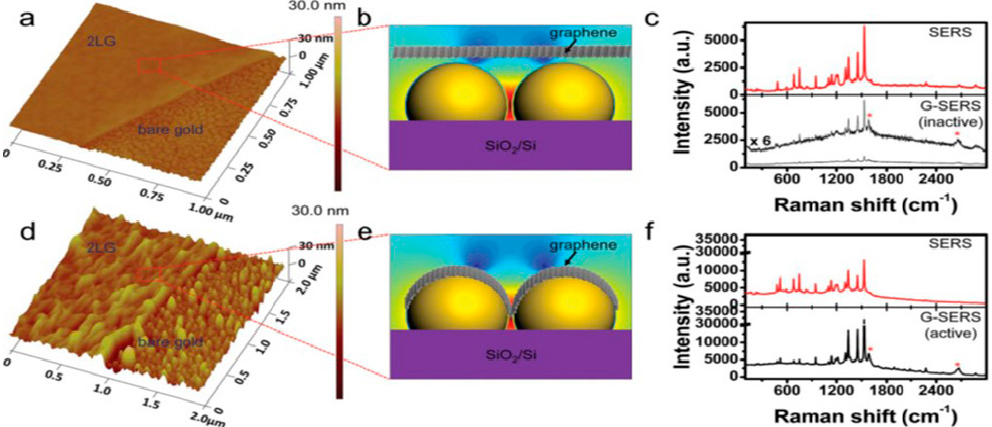
Figure 12. Morphology-dependent SERS performance of normal SERS and graphene-mediated SERS (G-SERS). ( a , d ) AFM images of a bilayer graphene (2LG)-covered 8-nm gold film ( a ) before, and ( d ) after annealing, showing both the bare gold regions and graphene-covered regions; ( b , e ) Schematic illustration of the contact state between graphene and AuNS correspond to the enlarged regions; ( c , f ) SERS performance of normal SERS (top) and G-SERS regions (bottom) ( c ) before, and ( f ) after annealing, respectively. “*” marks the G and G ′ band of the 2LG. The figure is adapted from [198], with permission from ©2013 Wiley.